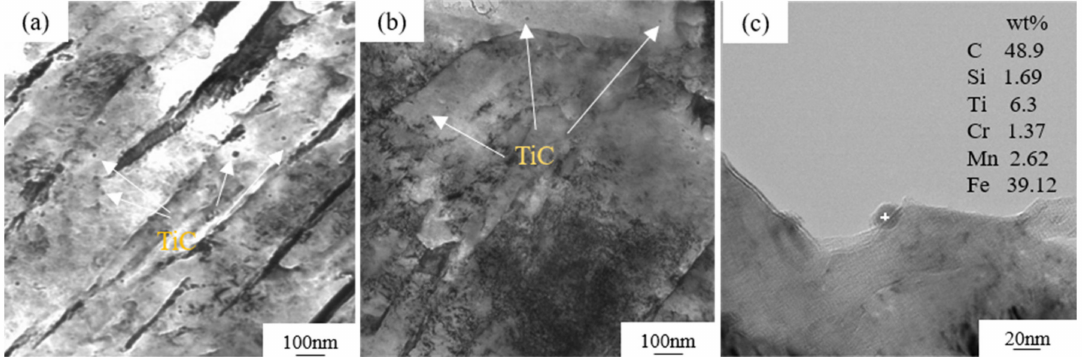
Figure 5. TEM analysis of nano-scale TiC carbides precipitated in experimental steels heated at 880 ◦ C for 3 min then air cooling: ( a ) steel A, ( b ) steel B and ( c ) chemical composition of